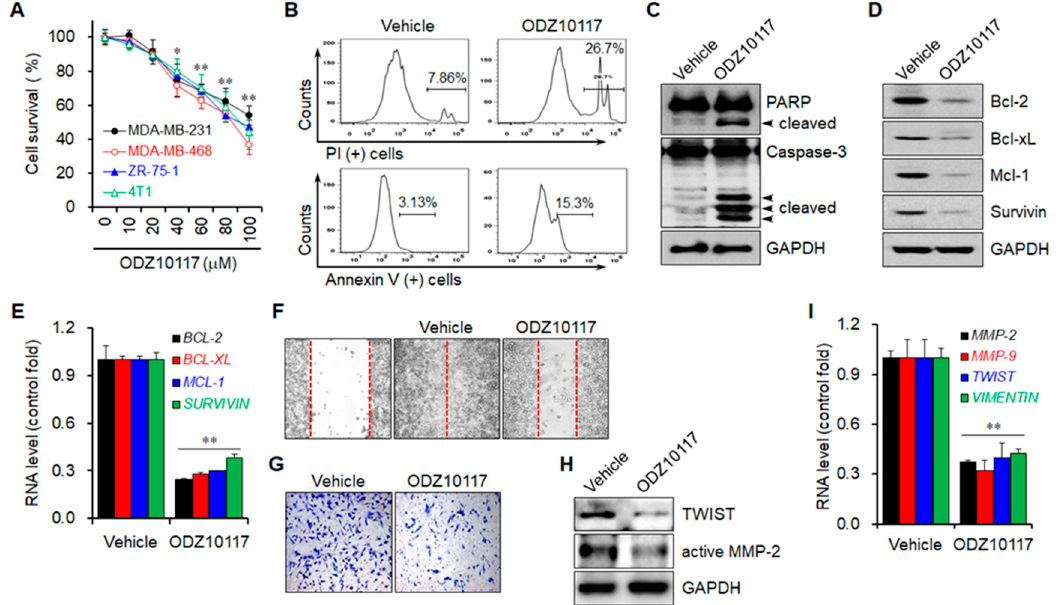
Figure 6. ODZ10117 induces apoptotic cell death and decreases migration and invasion of breast cancer. ( A ) Cells were incubated for 24 h with various concentrations of ODZ10117 and cell viability was determined. ( B – E ) MDA-MB-231 cells were incubated for 24 h with either vehicle (0.1% DMSO) alone or ODZ10117 (40 µ M), and then performed FACS ( B ), immunoblot ( C , D ), and qPCR ( E ) analyses. 2D graphs indicate PI- (upper) or Annexin V-positive (bottom) cells. ( F – I ) MDA-MB-231 cells were incubated for 24 h with either vehicle (0.1% DMSO) alone or ODZ10117 (40 µ M), and then performed wound healing ( F ) and Matrigel invasion ( G ) assays or immunoblot ( H ) and qPCR ( I ) analyses. Magnification, 200 × . GAPDH served as a loading control. Data are represented as mean ± SEM of three independent experiments. * p < 0.05 and ** p < 0.005 compared to the vehicle-treated group.